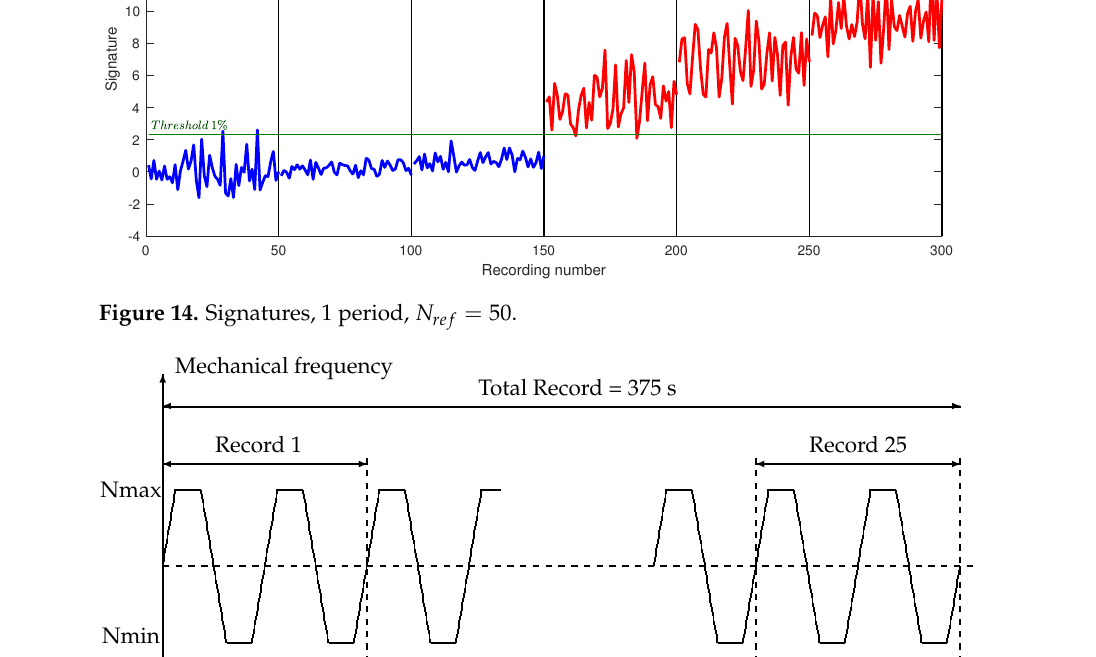
Figure 15. Speed profile for experimental